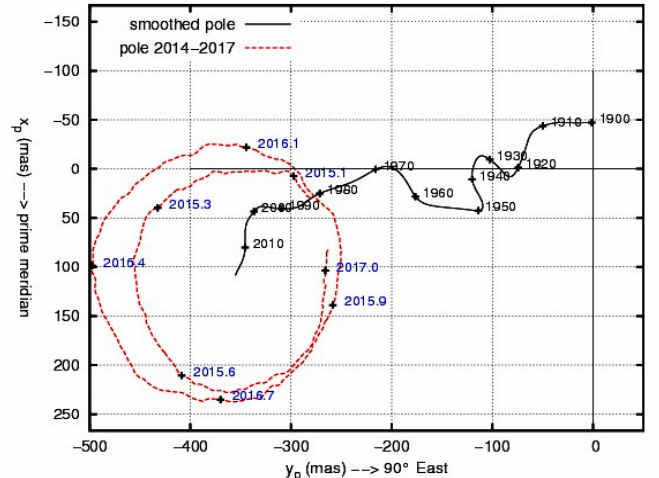
Fig. 1 . The movement of the North Middle Pole of the Earth in the definition of IERS for the period 1900 – 2014 and the flood of IERS. Coordinates are given in thousandths of arc seconds (mas) for the period 2014 – 2017. Figure source:http://hpiers.obspm.fr/eoppc/eop/eopc01/mean-pole.jpg.